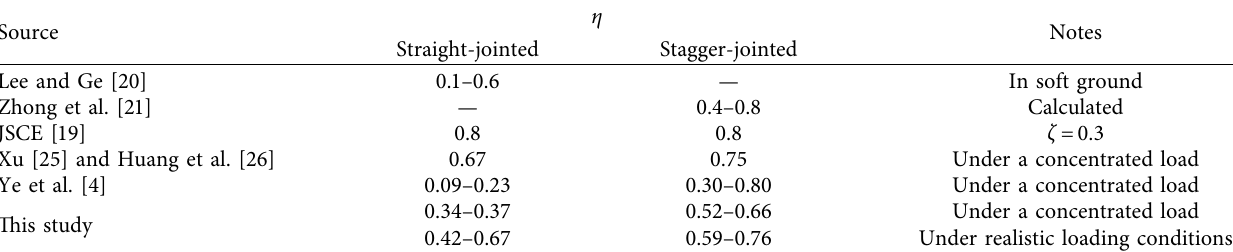
Table 3: Values of η obtained in this paper and previous